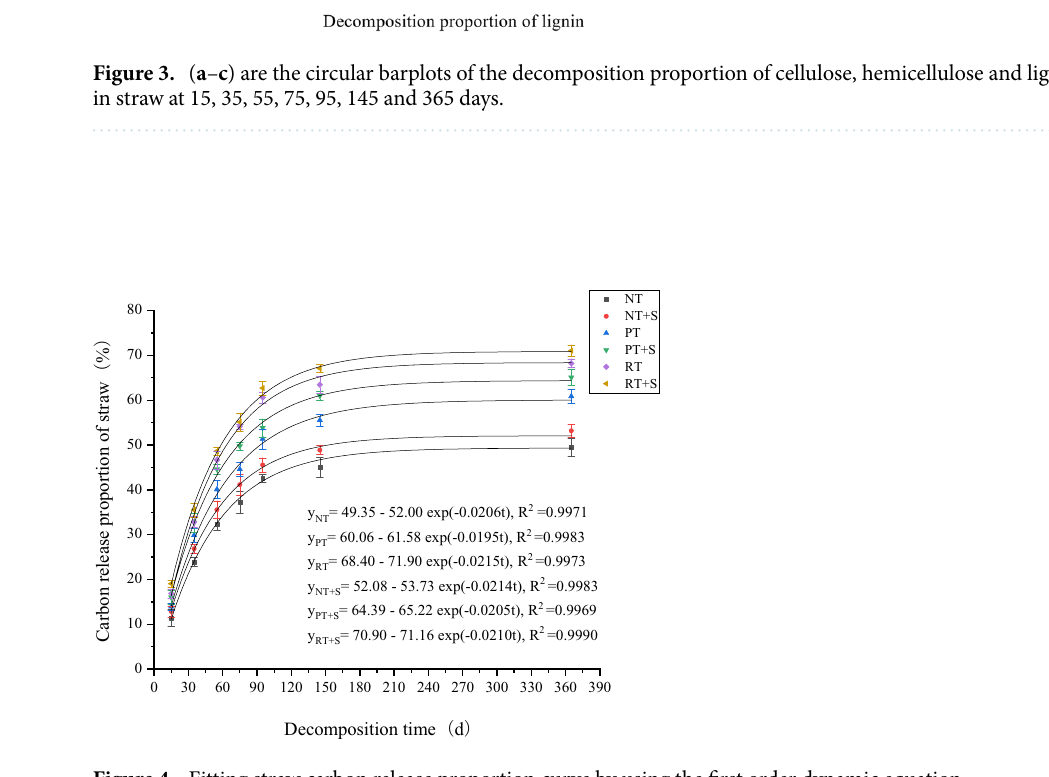
Figure 4. Fitting straw carbon release proportion curve by using the first order dynamic